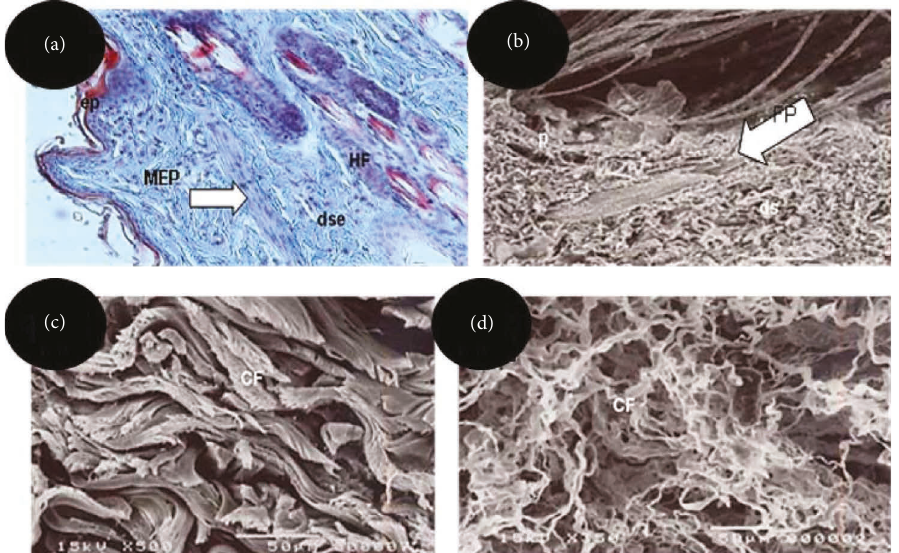
Figure 4: (a) Photomicrograph of a histological section of rabbit leather, illustrating the epidermis (ep) and superficial dermis (dse), containing the hair erector muscle (HEM) and hair follicle (HF). Staining: Masson’s trichrome. Objective lens: 20X; (b) scanning electron micrographs illustrating the superficial dermis (ds), the hair follicle (FP), and hair (p) of various thicknesses found in the skin before the hair removal tanning process; (c, d) Scanning electrographs illustrating the distribution of collagen fibers (CF) in the dermis of rabbit leather; (d) loose collagen fibers on the flesh side after